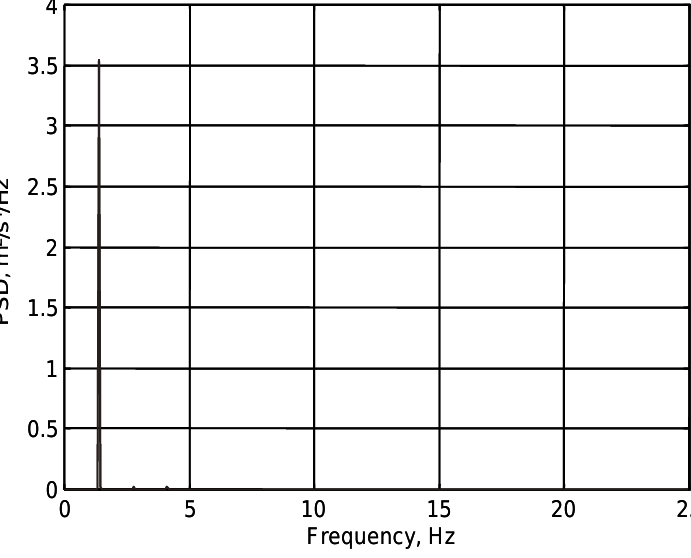
Fig. 8. Sprung mass acceleration (system response) power spectral density due to a 1.4 Hz pure tone excitation for a soft damper.